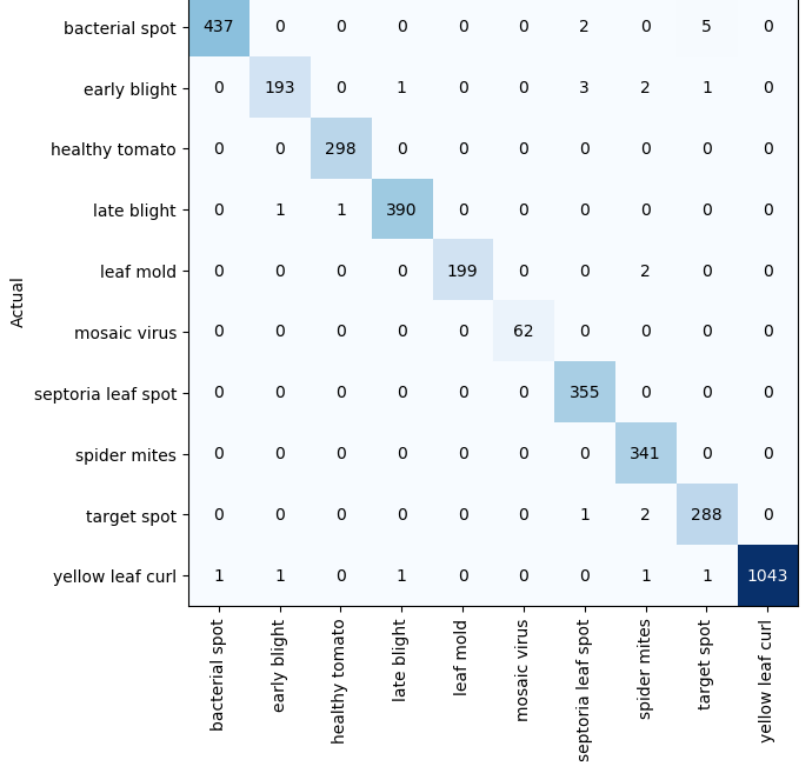
Figure 3. Confusion matrix for network depth = 50.